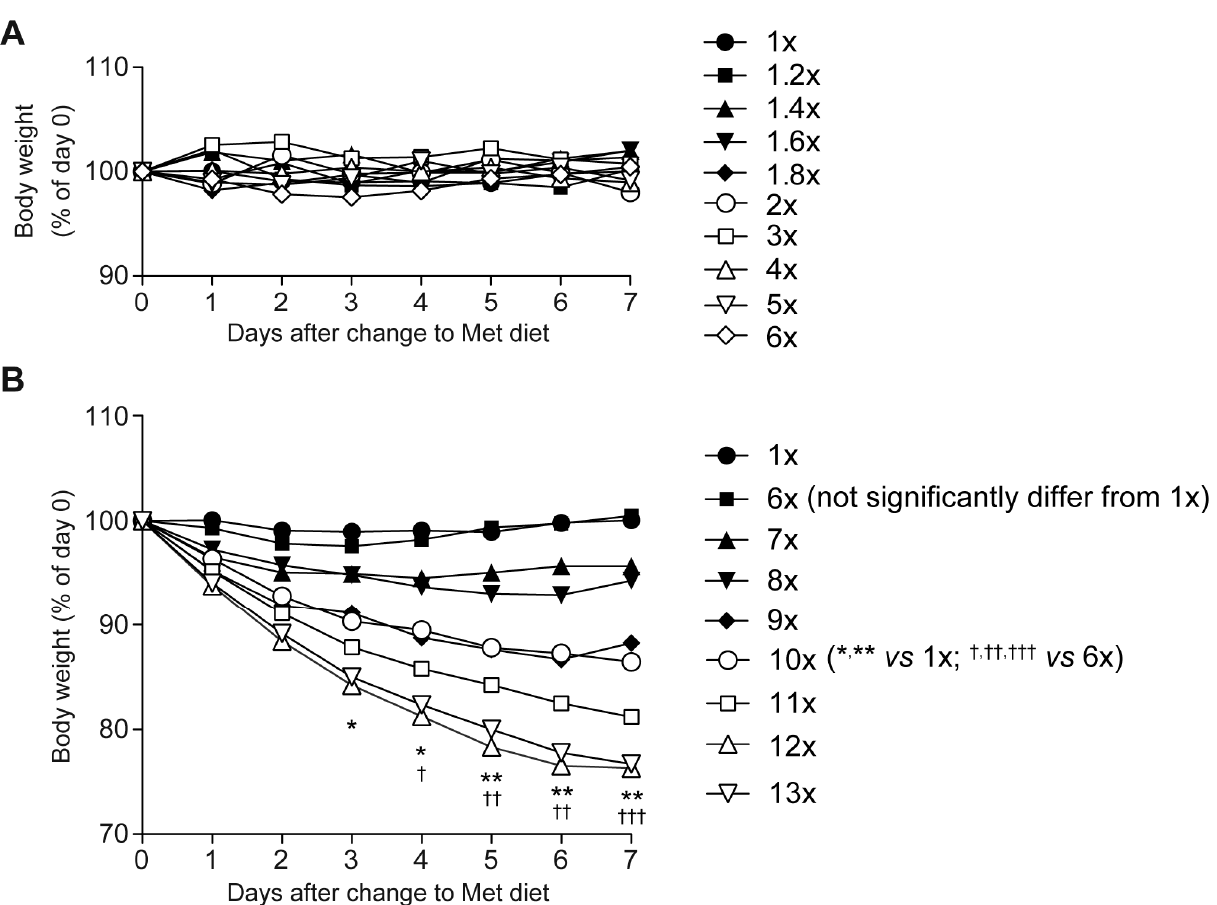
Figure 1. Impact of one-week high-methionine (Met) diet on body weight. Adult C57BL/6J male mice were ad libitum fed a standard CE-2 rodent diet (0.440% Met) until 8–9 weeks of age and then fed CE-2 (1×Met) or CE-2 containing graded concentrations of Met [1.2×Met [0.528%]–6×Met [2.64%] ( A ); 6×Met [2.64%]–13×Met [5.72%] ( B )] for a week. Body weights were measured daily at 11 a.m. Data are the mean of four mice. Bodyweight decreases were evident with the 7×Met–13×Met diet. Statistical analysis was done by one-way ANOVA with a Tukey’s multiple comparison test at each time point. For clarity, only analyses between 1×Met, 6×Met, and 10×Met samples are shown; the differences were significant in * p < 0.05 and ** p < 0.01 versus 1×Met; † p < 0.05, †† p < 0.01, and ††† p < 0.001 versus 6×Met.